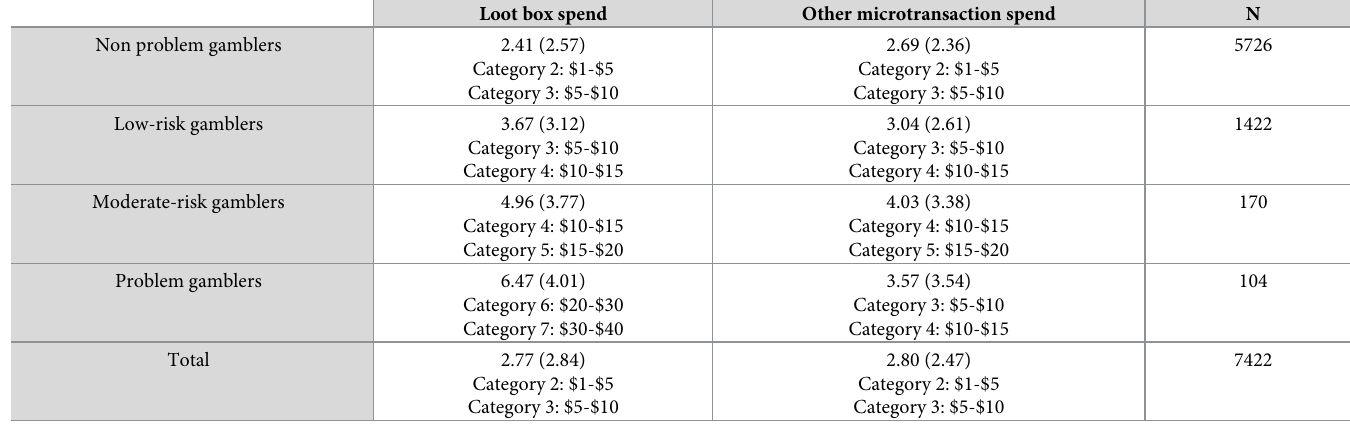
Table 1. Means and standard deviation of both loot box spending and other microtransaction spending, split by problem gambling severity. Standard deviations in brackets. The spend statistics reported here are mean categories, rather than a conversion into dollar figures. Relevant categories for each mean score are given below each